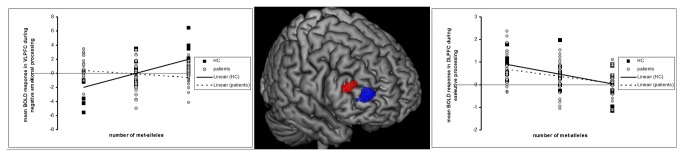
Prefrontal cortical activity correlated with number of met-alleles during emotional and working memory processing: hypothesis testing.Red represents a positive correlation between number of met-alleles during processing of negative emotional facial expressions only in HC. The graph depicting the correlation between activity and number of met-alleles is located on the left. Blue represents a negative correlation between number of met-alleles and activity during working memory over all subjects. The graph depicting the correlation between activity and number of met-alleles is located on the right. The threshold was set at p<.001 uncorrected and the peak voxel had to survive p<.05 family wise error (FWE) corrected for the spatial extent of the PFC with a small volume correction (see methods).